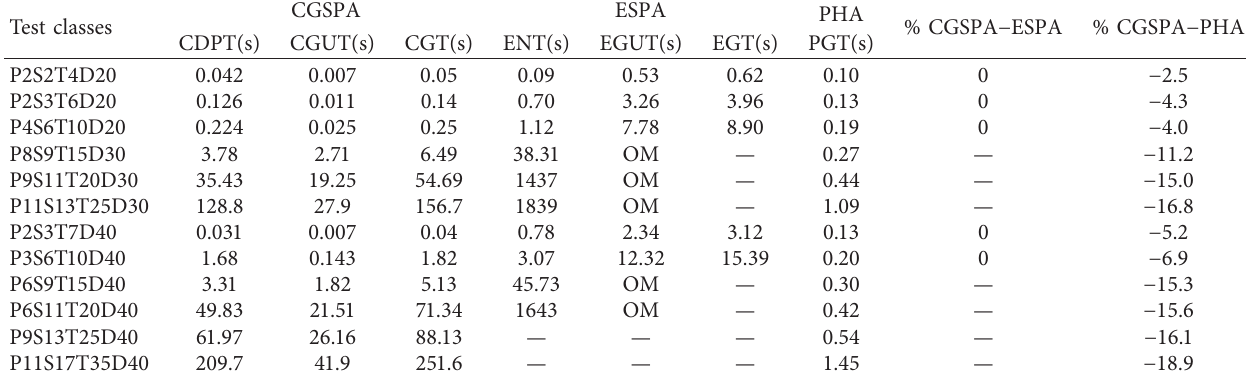
Table 6: CGSPA performance analysis.